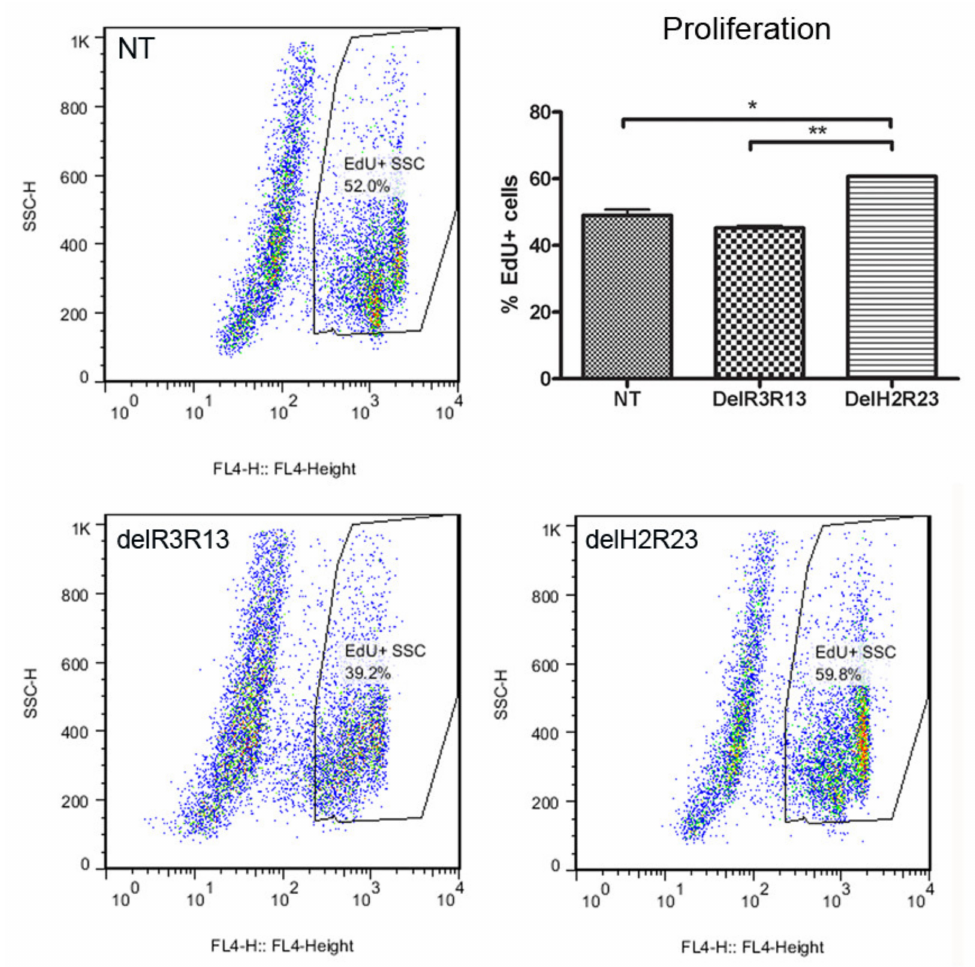
Figure 3. E ff ects on cell proliferation after cells were transduced with mini-dystrophin lentivirus driven by the spleen focus-forming virus (SFFV) promoter. Cells transfected with mini-dystrophin ∆ R3R13 had no e ff ect on cell proliferation, while ∆ H2R23 significantly increased the proliferation of human muscle-derived cells. * p < 0.05; ** p <